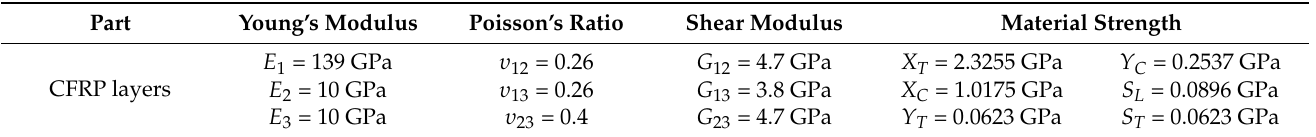
Table 1. Used material properties to compute the failure envelopes for the CFRP material [9].